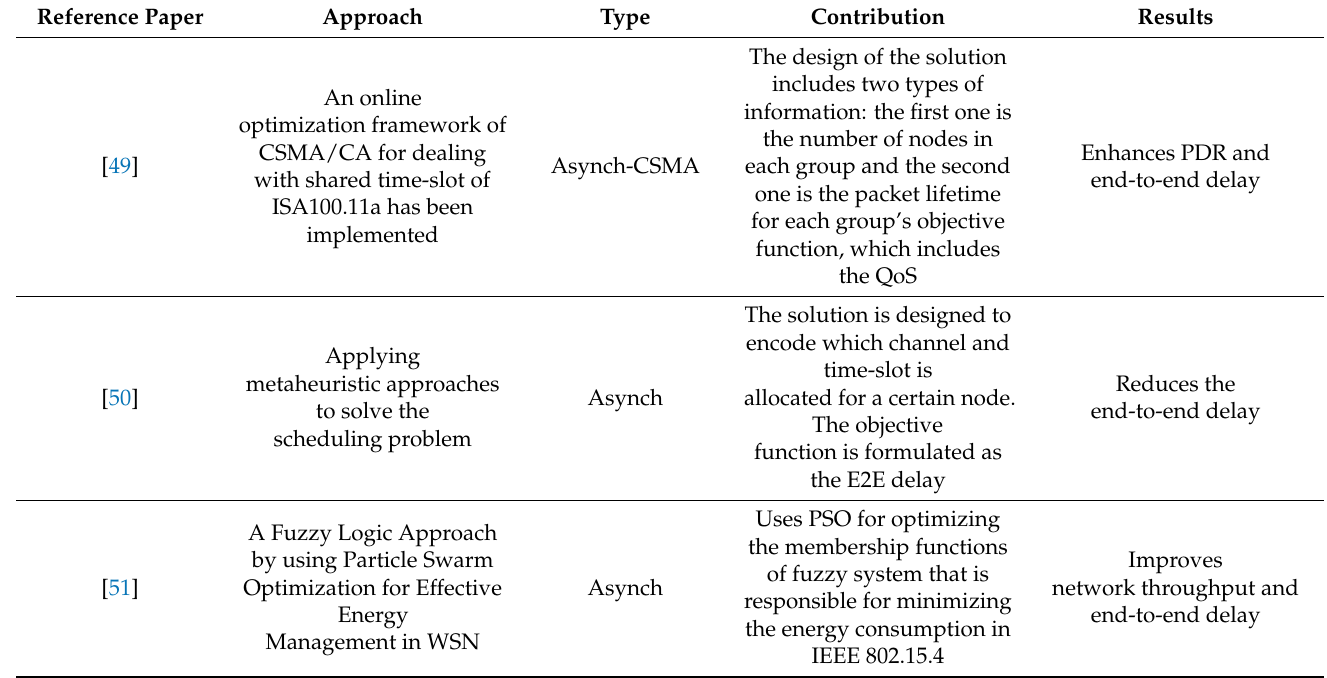
Table 4. Meta-heuristic-based MAC